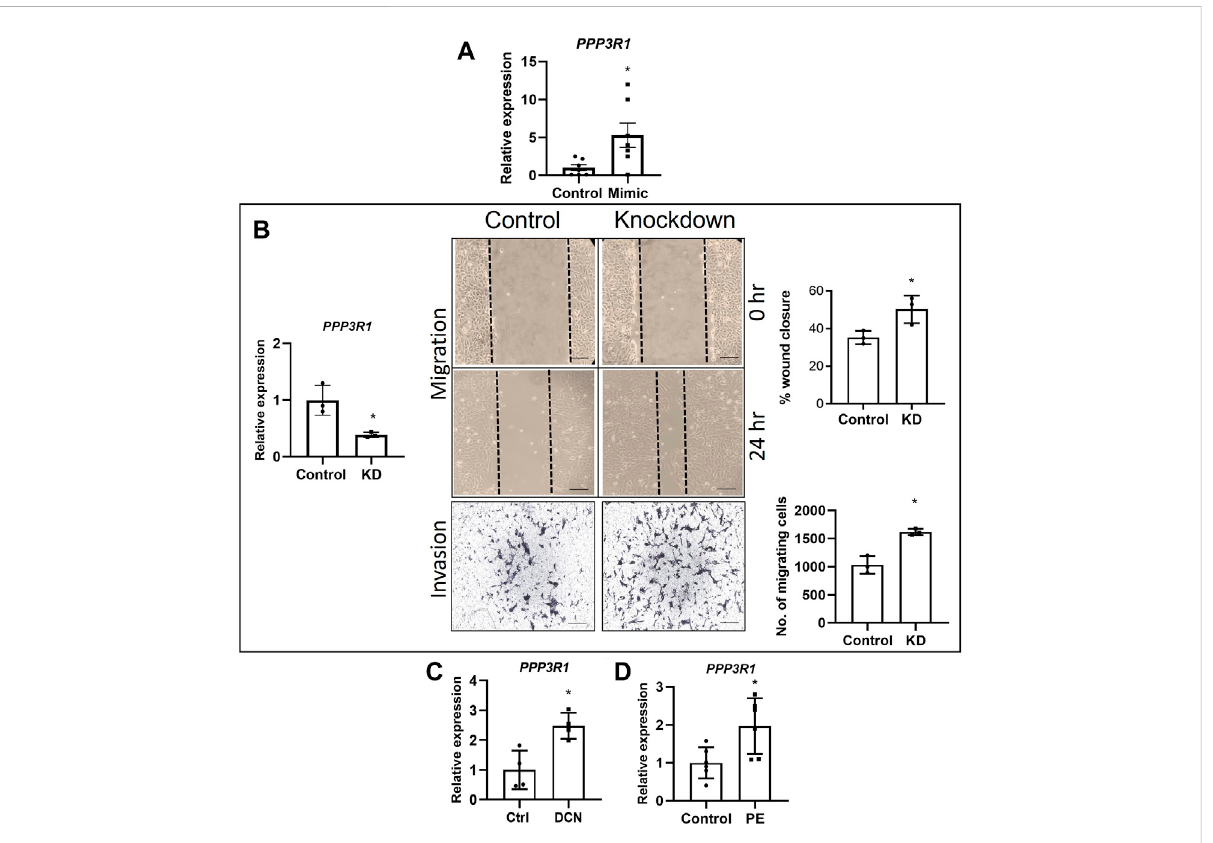
FIGURE 4 Roles of PPP3R1 in trophoblast functions. (A) miR-512-3p overexpression (miR-512-3p mimic) resulted in signi fi cant increase in PPP3R1 con fi rmedbyqRT-PCR(* p < 0.05, n =7replicates). (B) qRT-PCRshowingknockingdown PPP3R1 inHTR-8/SVneocells(60%knockdown,* p < 0.05) and the resulting effect on migration and Invasion assays. Migration assay performed using scratch assay. Images taken at 0 h and 24 h (20×), measured by the percentage of wound closure at 24 h showing signi fi cant increase in wound closure in PPP3R1 knockdown cells. Invasion assay images (200 μ m) shown for control and knockdown cells taken at 48 h measured by calculating the number of cells migrating through the Matrigel covered membrane. (* p < 0.05, n = 3). (C) qRT-PCR showing signi fi cant increase of PPP3R1 mRNA expression after exogenous DCN treatment of HTR-8/SVneo cells (* p < 0.05, n = 4) and (D) in placentae from PE (* p < 0.05, n = 5). All analysis were performed using Student ’ s t -test. Error bars extending to ±